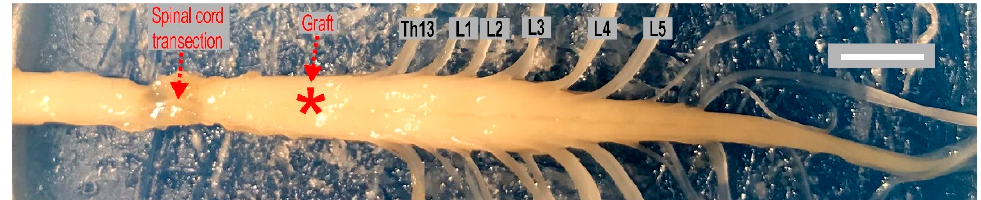
Figure 10. Spinal cord of adult WAG rat (Wistar Albino Glaxo inbred strain) with a clear scar in the site of total transection and an approximate location of a graft performed in our experiments. Scalebar: 5 mm. Abbreviations: Th13, L1-5 thoracic 13, lumbar 1–5 spinal cord segments.